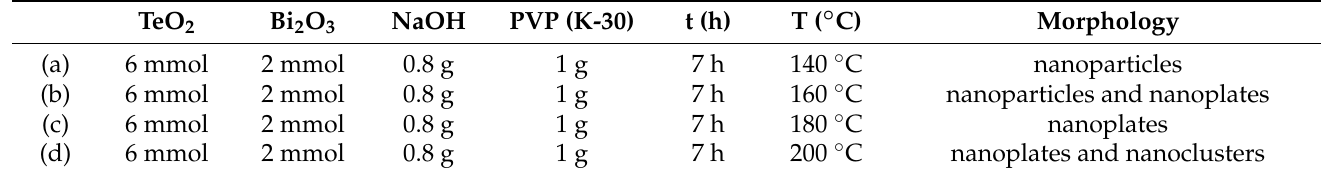
Table 1. A series of temperatures influenced on the morpholoy of Bi 2 Te 3